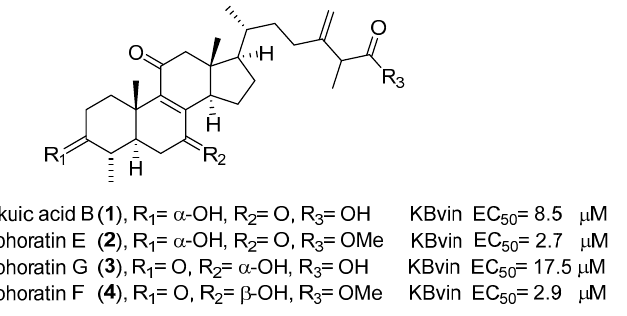
Figure 1. Cytotoxicity of compound 1 – 4 isolated from T. camphoratus on KBvin cell lines.